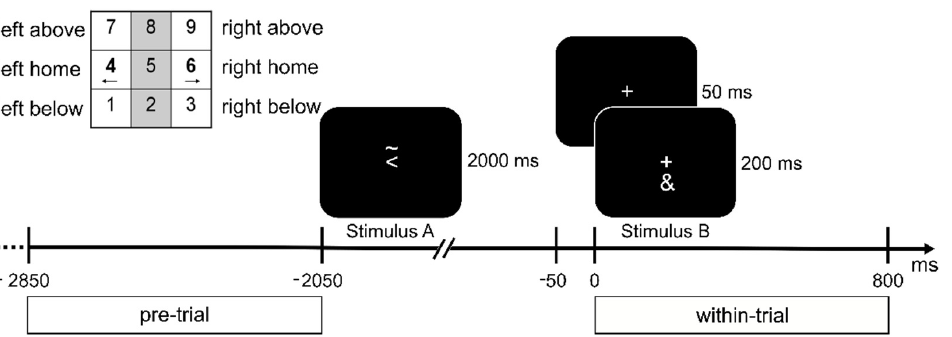
Figure 1. Illustration of the task. Presented stimuli are visualized on a time scale relative to Stimulus B. A fixation cross was shown at all times. In the top left corner, the layout of the response keys (num pad on a keyboard) is shown. Participants had to respond to the Stimuli with the corresponding left or right index fingers. The figure depicts a feature overlap trial: both Stimulus A and B require a response with the left hand, as indicated by the arrowhead in Stimulus A and the ‘&’ symbol in Stimulus B (refer to Methods). Below the time axis, the time frames chosen for the pre- and within-trial interval are outlined.